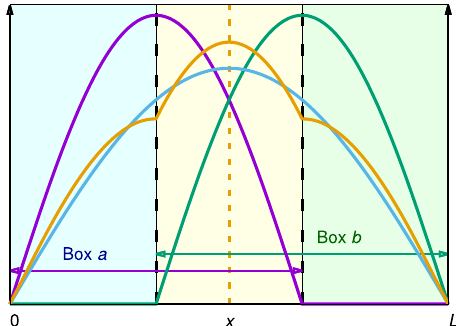
Fig. 2 A model for the wavefunction reference bias. A one-electron one- dimensional box of length L built from the interpenetration of two smaller left ( a , blue) and right ( b , green) boxes of length 2/3 L . The interpenetration region is depicted in yellow. The ground states of an electron initially con fi ned in either the a or b boxes, ϕ a , ϕ b are shown as the purple and green solid curves. If the impermeable walls (dashed black lines) are released, the electron delocalizes, and its ground state, Ψ is depicted in cyan. When Ψ is approximated by the gerade linear combination of ϕ a and ϕ b , Ψ = N ( ϕ + ϕ S ≈ 0.2153. The spatial partitioning of the large a b ), in orange, ab box into two equivalent non-interpenetrating regions of length L /2 is depicted by the short-dashed orange